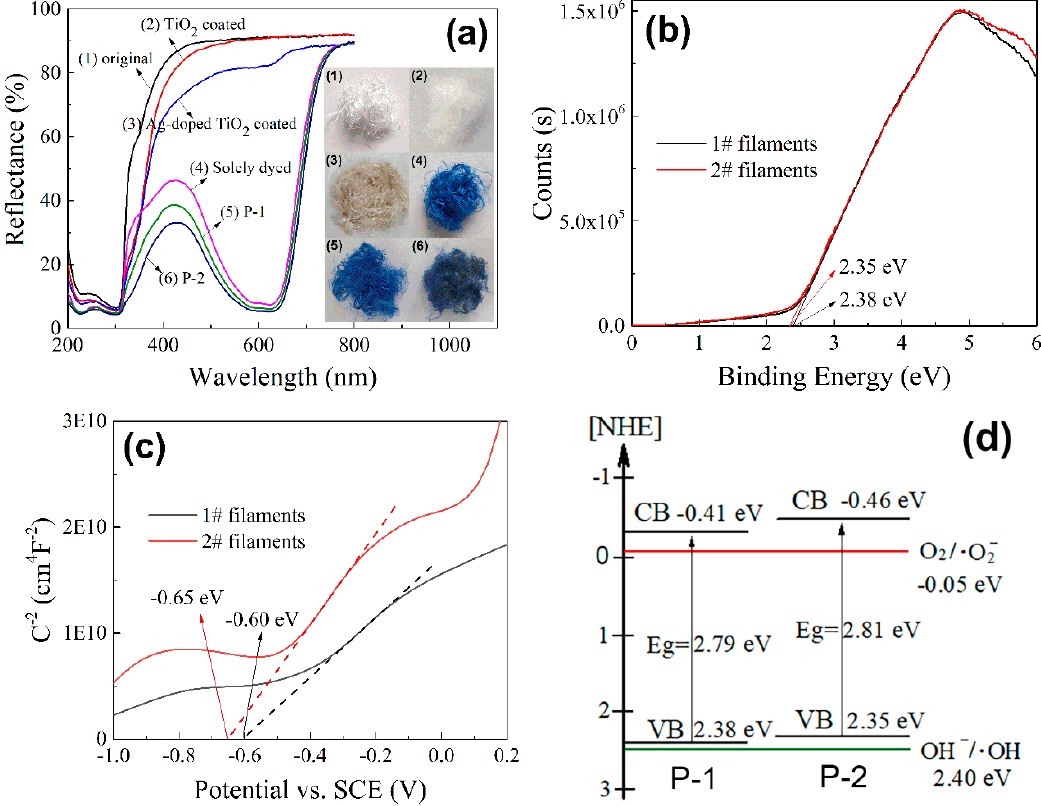
Figure 6. ( a ) UV-visible diffuse reflectance spectra, ( b ) UV photoelectron spectroscopy (UPS) spectra, ( c ) Mott–Schottky (M–S) curves and ( d ) the electronic band structure diagram of the P–1 and P–2 filaments. Table 2. Fitting parameters of the time-resolved PL data using two-exponential decay kinetics. PET